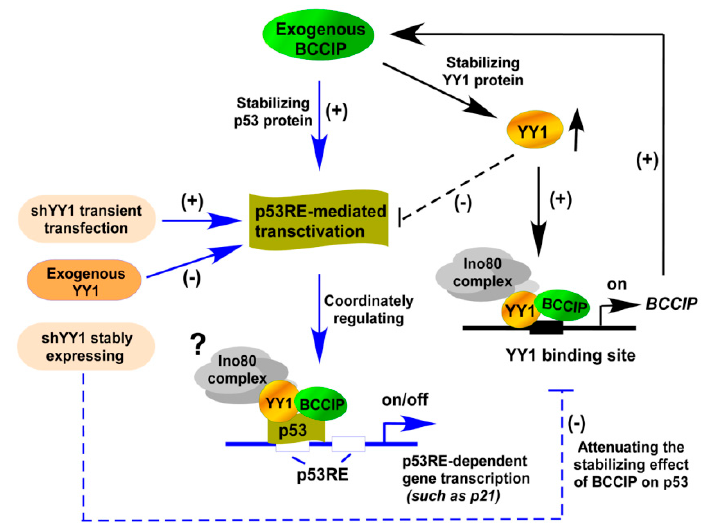
Figure 9. Coordinated regulation of p53RE-dependent gene transcription by p53 / BCCIP / YY1. BCCIP promotes p53RE-mediated transactivation by binding to and stabilizing p53 and further activates p21 transcription. This pathway is regulated by intracellular YY1 protein levels. Increased YY1 inhibits p53RE-mediated transactivation, and the opposite e ff ect is seen in transient knockdown of YY1. However, stable knockdown of YY1 attenuates BCCIP transcription, further a ff ecting p53 stability, which suggests that there may be feedback inhibition. Black solid arrows, published data [17]; black T dotted arrow, indirect inhibition; blue solid arrows, possible pathway of p53RE-dependent gene transcription; blue T dotted arrow, stably expressing shYY1 a ff ect the INO80 / YY1-BCCIP pathway.